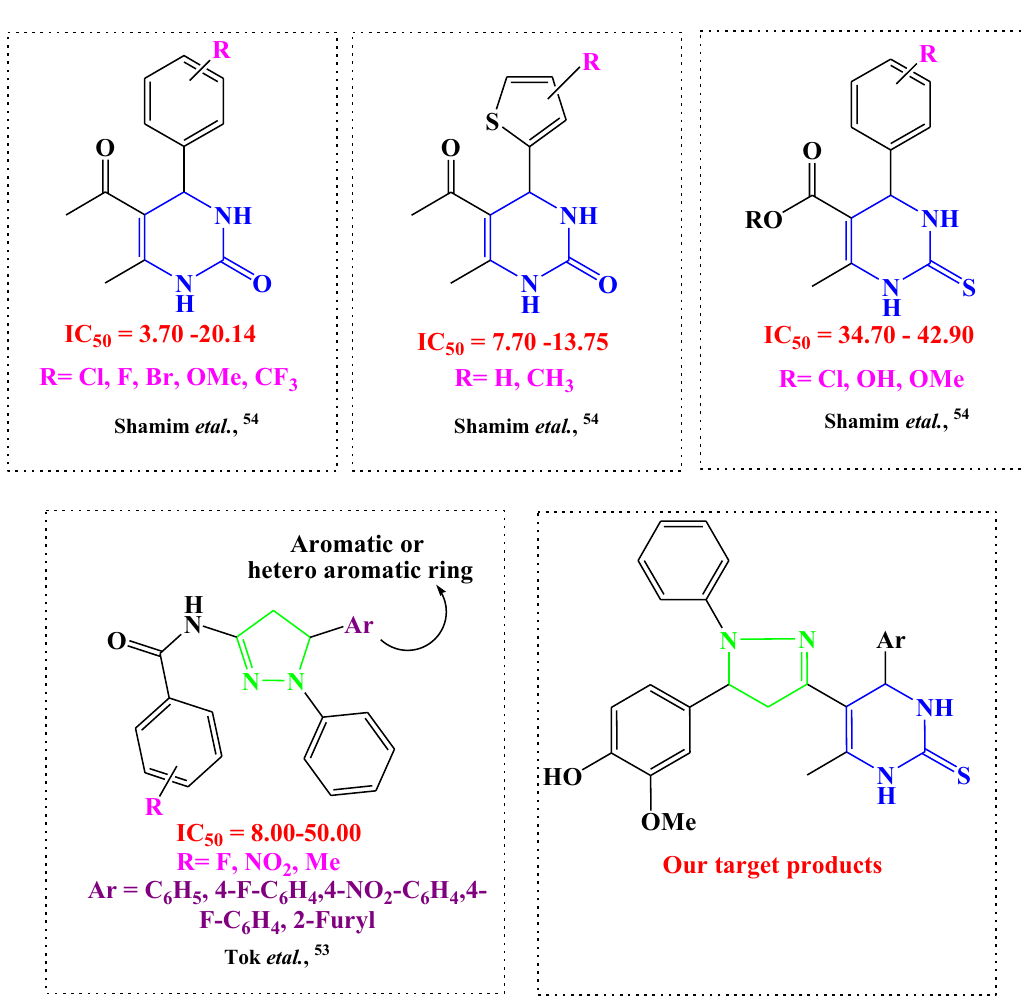
Figure 10. Rational design of newly synthesized pyrimidine-2-thione